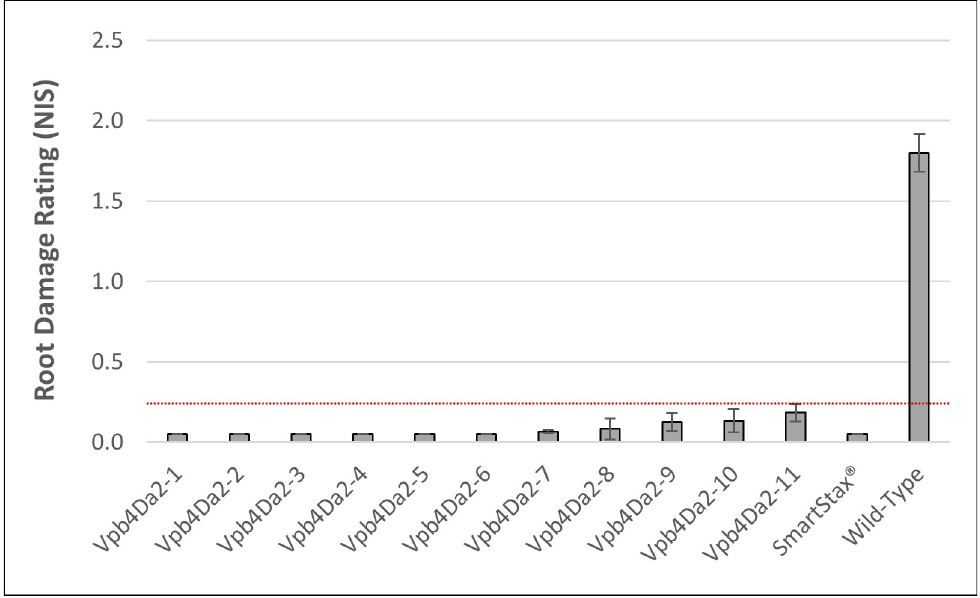
Fig 1. Vpb4Da2 transgenic maize provides commercial-level root protection against WCR in a growth chamber whole-plant assay. Mean ( ± SEM) NIS in growth chamber whole-plant root protection assays are shown, in which approximately 2,000 eggs from a lab WCR colony (Waterman) were infested on individual maize plants from Vpb4Da2 transgenic lines, SmartStax 1 expressing both Cry3Bb1 and Cry34Ab1/Cry35Ab1, and wild-type maize control. Dotted line in red color shows the commercial threshold of NIS 0.25, error bars represent